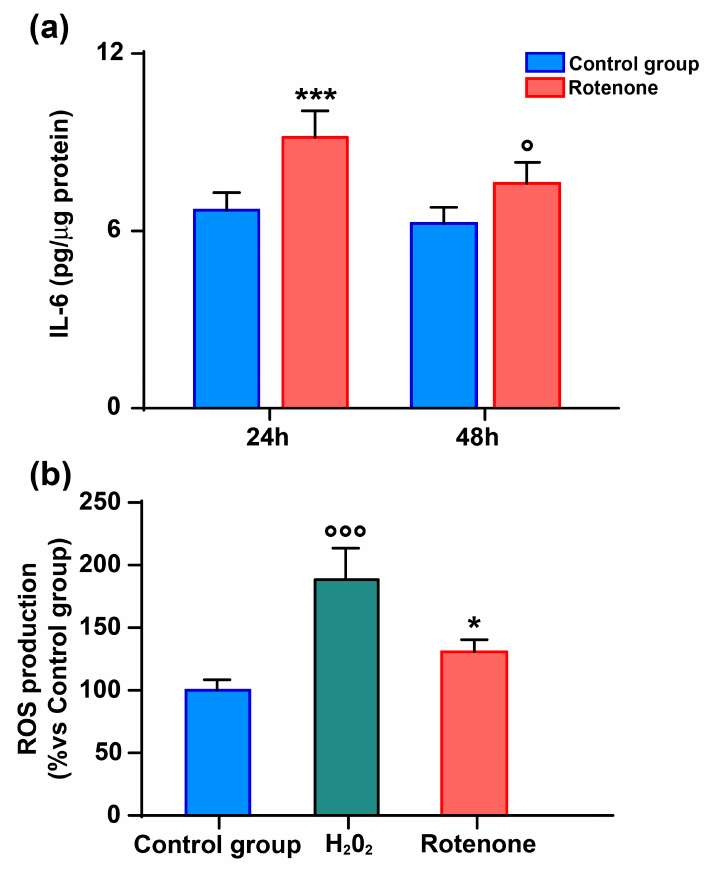
Figure 1. ( a ) Effect of oxidative stress on IL-6 production by HMC3 cells. After 24 h, the treatment with rotenone (100 nM) significantly increased the release of IL6 when compared to unstimulated cells. Furthermore, prolonged oxidative stress did not lead to additional IL-6 release but its levels remain significantly higher when compared to the control group. Each column represented the average ± SEM ( n = 5) normalized by the total protein content measured per well. Data were analyzed by two-way ANOVA followed by Holm–Šídák post hoc test. ° p < 0.05 vs. control group 48 h; *** p < 0.001 vs. control group 24 h. In ( b ), bars illustrate the ROS production in HMC3 cells following rotenone treatment (100 nM). Each bar represents the mean ± SEM ( n = 5) of the percentage of the fluorescence, normalized with the respective value of the control. Data were analyzed by one-way ANOVA followed by Bonferroni post hoc test. * p < 0.05 vs. control group; ◦◦◦ p < 0.001 H 2 O 2 vs. rotenone and control